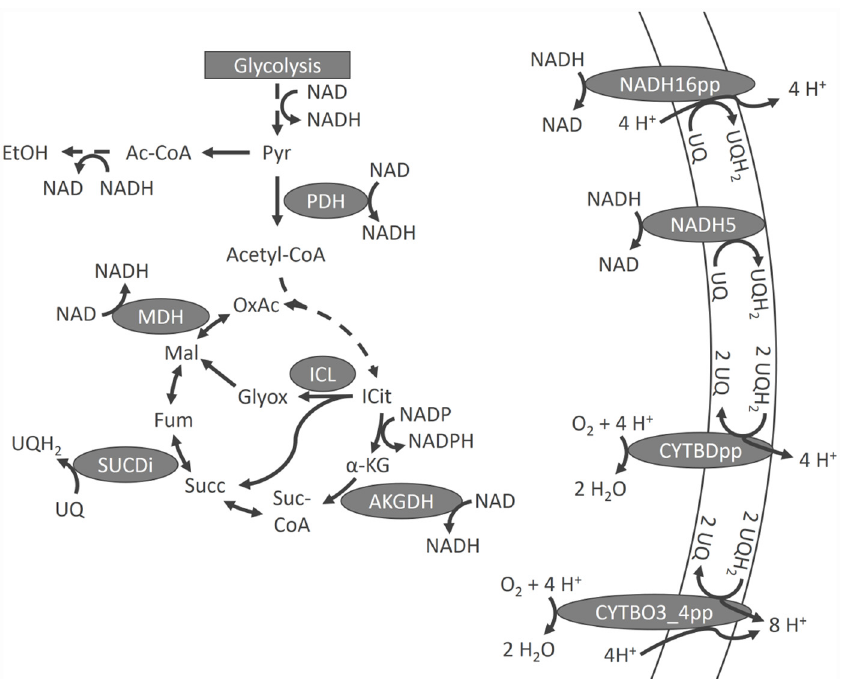
Fig 1. Outline of central aerobic metabolism. Reaction nomenclature according to iJO1366 [14]. Pyr, pyruvate; ICit, Isocitric acid; α -KG, α -ketoglutaric acid; Suc-CoA, succinyl-coenzyme A; Succ, succinic acid; Mal, malic acid; OxAc, oxaloacetic acid; UQ, ubiquinone; UQH 2 , ubiquinol; only redox cofactors are considered.